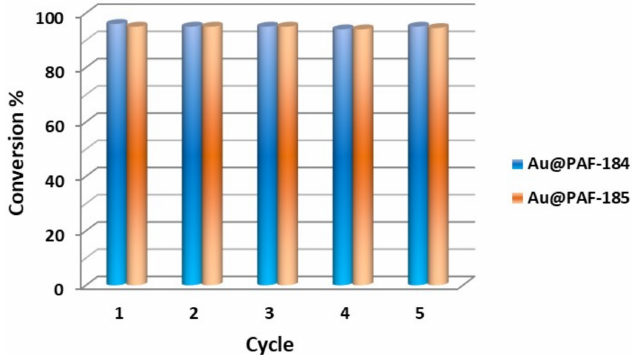
Figure 4. Schematic diagram of cycle